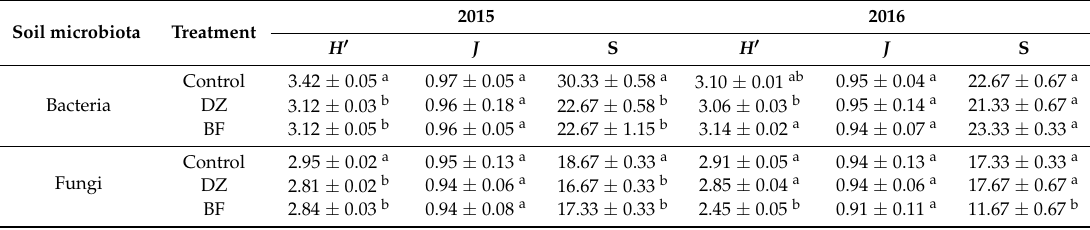
Table 3. Effects of different fungicides on the rhizosphere soil microbial diversity index. Soil microbiota